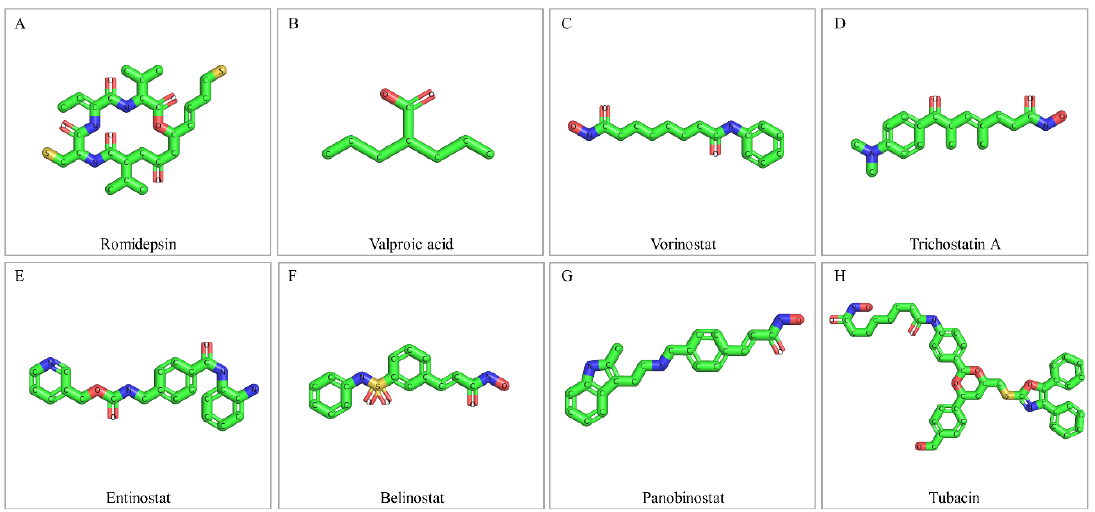
Figure 4. Graphical presentation of the most extensively investigated HDAC inhibitors (HDACis) in bladder cancer. Data were retrieved from the ChEMBL database [184] and visualized via